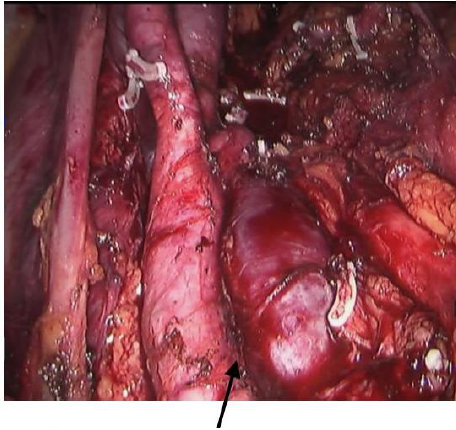
FIGURE 5. Common iliac